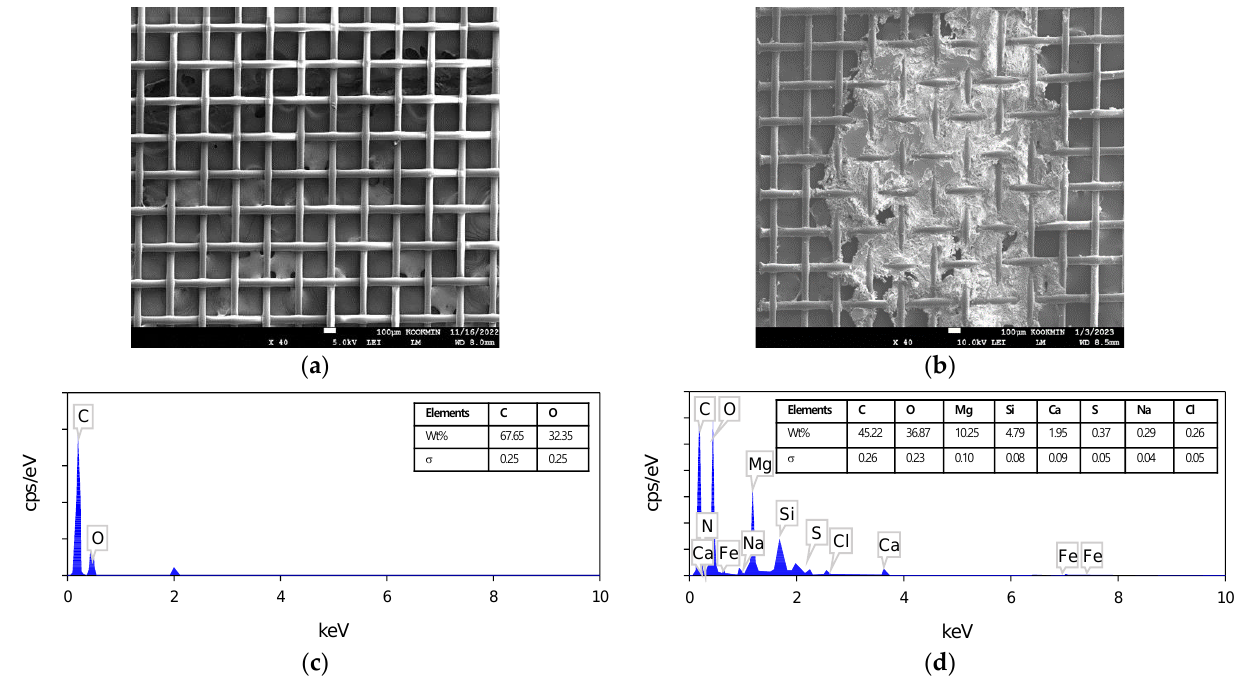
Figure 13. FE-SEM images and EDS spectrum of the spacer surface before and after use: ( a ) virgin spacer; ( b ) spacer fouled by Ca, Mg and Si at 40 times, respectively; ( c,d ) show the EDS spectra of ( a,b ), respectively.